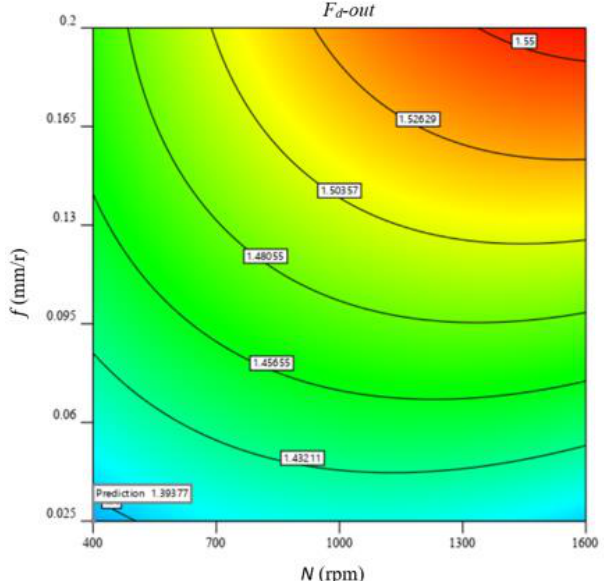
Figure 17. Contour plot of push-out delamination factor optimization at workpiece thickness of 7.7 mm.